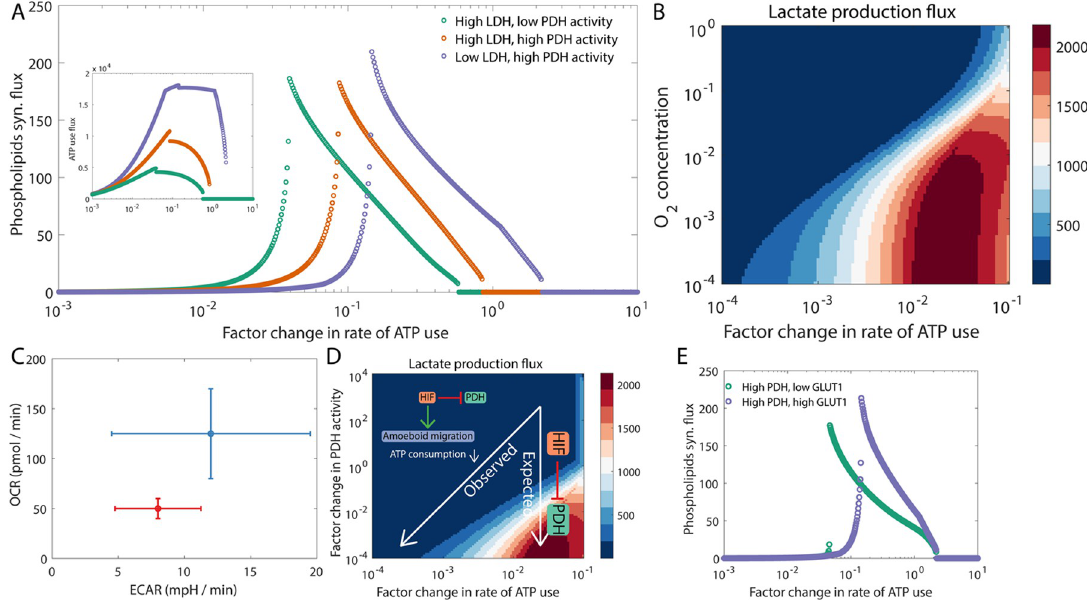
Fig 2. Rate of ATP consumption by tumor cells can modulate the preference for aerobic glycolysis versus oxidative phosphorylation. (A) The regime that maximizes the phospholipids synthesis flux depends on the rate of ATP consumption. The inset shows that the flux through pathways that consume ATP is maximized when the activity of PDH is high, i.e., when most of the glucose carbon enters the TCA cycle. (B) The rate of lactate production by tumor cells can depend not only on the availability of oxygen in the microenvironment but also on the rate of ATP consumption. (C) Change in the metabolic profile of 4T1 cells upon HIF1 stabilization (red) as compared to the control (blue). The behavior shown is representative of that reported by te Boekhorst et al . [35] (see Fig 5E therein). ECAR: extracellular acidification rate, which correlates positively with the rate of lactate excretion by cells. OCR: oxygen consumption rate, which correlates positively with the flux through the TCA cycle / oxidative phosphorylation pathway. (D) Change in the metabolic profile of cells upon HIF1 stabilization (which inhibits PDH activity) as predicted by our model. The change labeled as expected is when the migratory phenotype (and the rate of ATP consumption) remains unchanged upon HIF1 stabilization. The change labeled as observed is when HIF1 stabilization is accompanied by a switch from actin-driven migration to amoeboid migration [35] which decreases the rate of ATP consumption during cell migration. (E) Under high PDH activity and very high ATP consumption rate, GLUT1 up-regulation can increase the phospholipids synthesis flux. Fluxes are in units of mM h -1 (millimolar per hour) and are shown at steady state. The discontinuities in panels A and E arise from the bistability caused by the positive feedback from the allosteric activation of PFK by fructrose-1, 6-biphosphate (see Fig